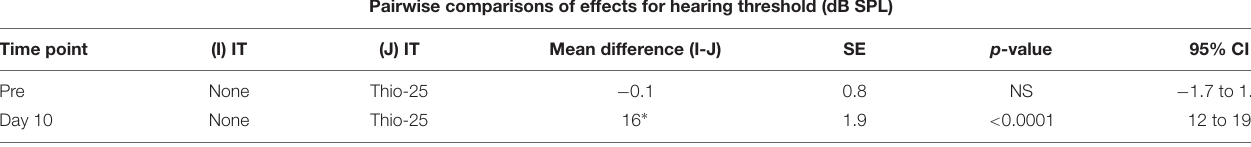
TABLE 2B | Pairwise comparisons of the analysis results presented in Table 2A . Pairwise comparisons of effects for hearing threshold (dB SPL)